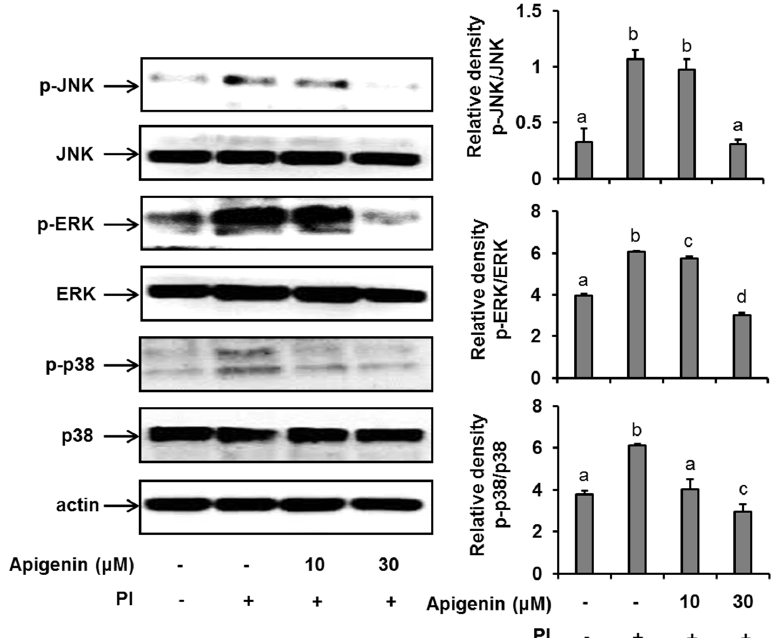
Figure 2. Effects of apigenin on MAPK cascade signaling pathways in HMC-1 cells. Cells were pre-treated with apigenin at indicated concentrations for 1 h prior to PI stimulation for 30 min. Western blot analysis was performed to evaluate the expressions of molecules of the MAPK cascade signaling pathways in the cells. The bands were quantitated using Image J analysis software tool. The data presented are the means ± SD of three independent experiments. Bars with different small case letters indicated statistically significant difference at p < 0.05. PI, phorbol-12-myristate 13-acetate (50 nM) and ionomycin (1 μM).